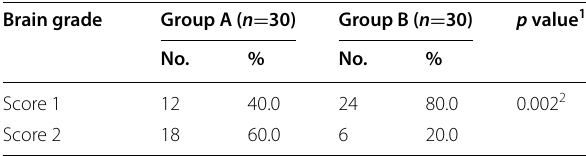
Table 1 Distribution of patients according to brain relaxation score after dural opening between the